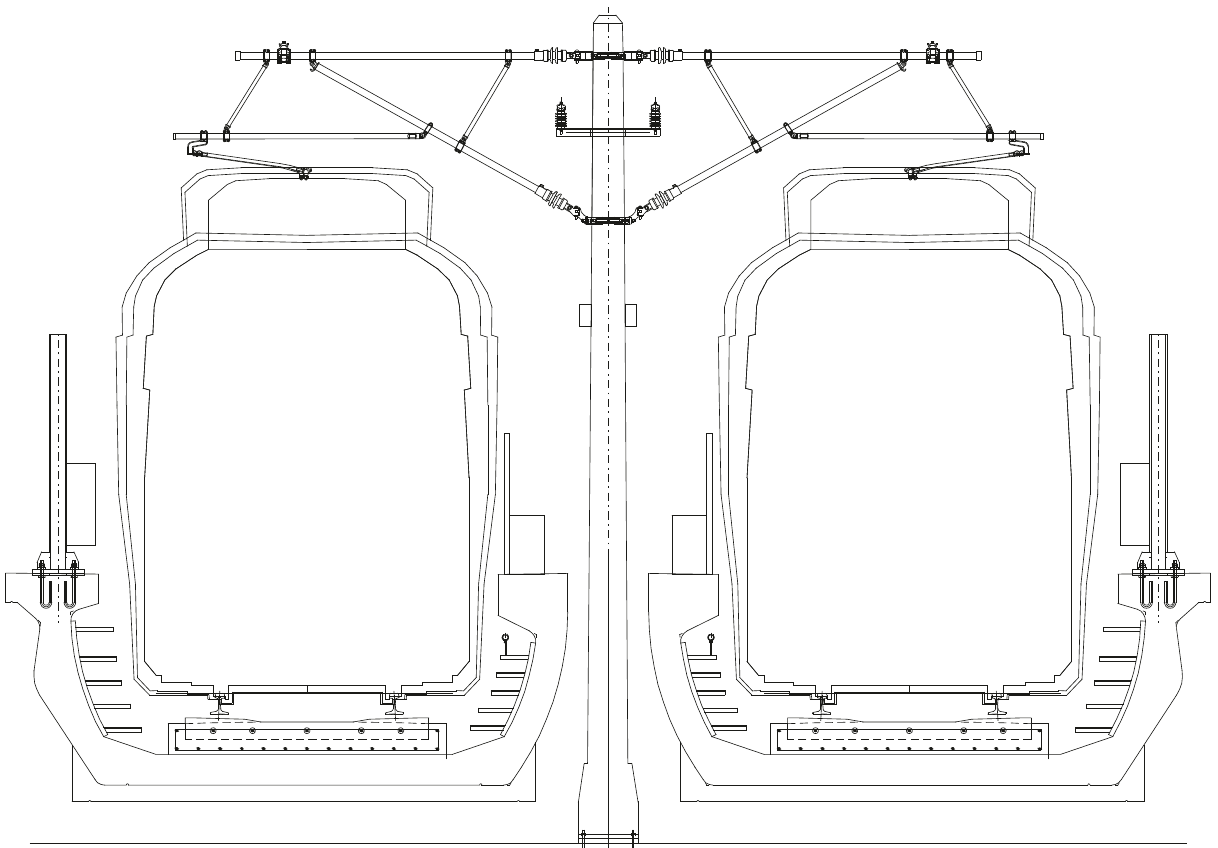
Figure 1: Structure diagram of U-shaped girder for urban rail transit.